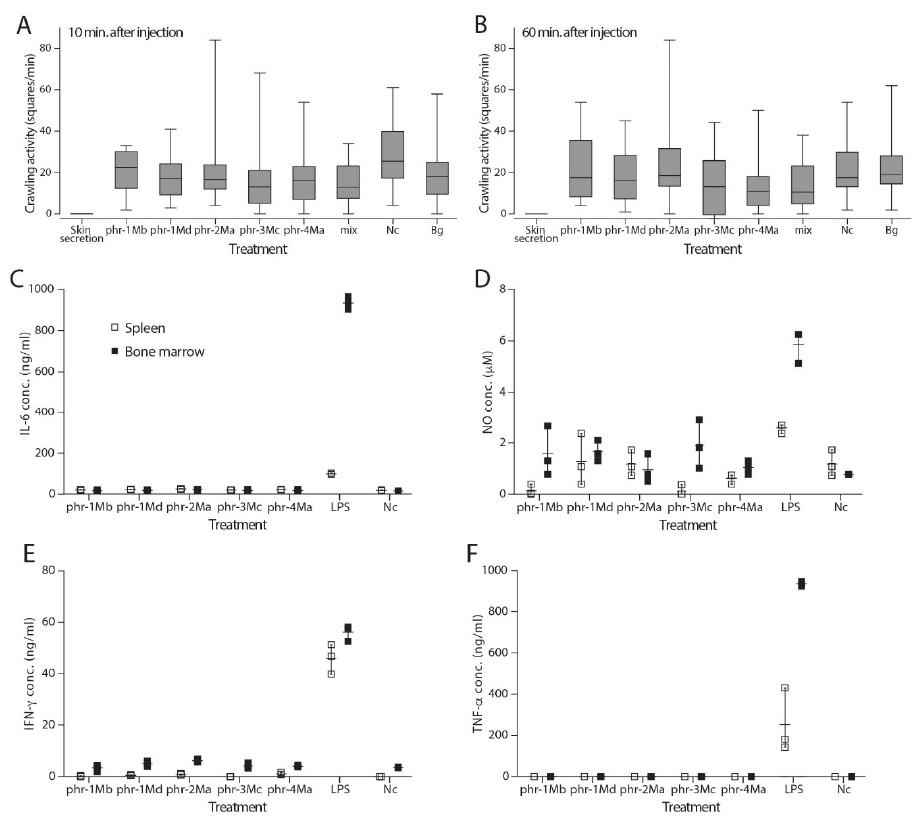
Figure 3. Assessing the insecticidal and inflammatory activity of P. microps skin secretion and its phrynomantin peptides. A-B) the effect of injecting 6× diluted skin secretion or peptide (20 µL at 1 mM) on crawling activity on wax moth larvae (n = 15-21) after 10 ( A ) and 60 min ( B ). C-F ) Effect of phrynomantins (100 µM) on levels of IL-6 ( C ), NO ( D ), IFN- γ ( E ) and TNF- α ( F ) in cell medium of mouse spleen (white squares) and bone marrow (black squares) cell cultures (n = 3). Data in A and B are shown as boxplots and in C-F as individual data points, showing the range (vertical line) and average (horizontal line). Overlapping symbols might appear as single data points. Peptides are labelled as phr (phrynomantin) with their respective peptide number (see Table 2), Bg = background (no injection), Nc = negative control (injection of water), mix = mixture of all tested phrynomantins (each at 1 mM), LPS = E. coli endotoxin/lipopolysaccharide.